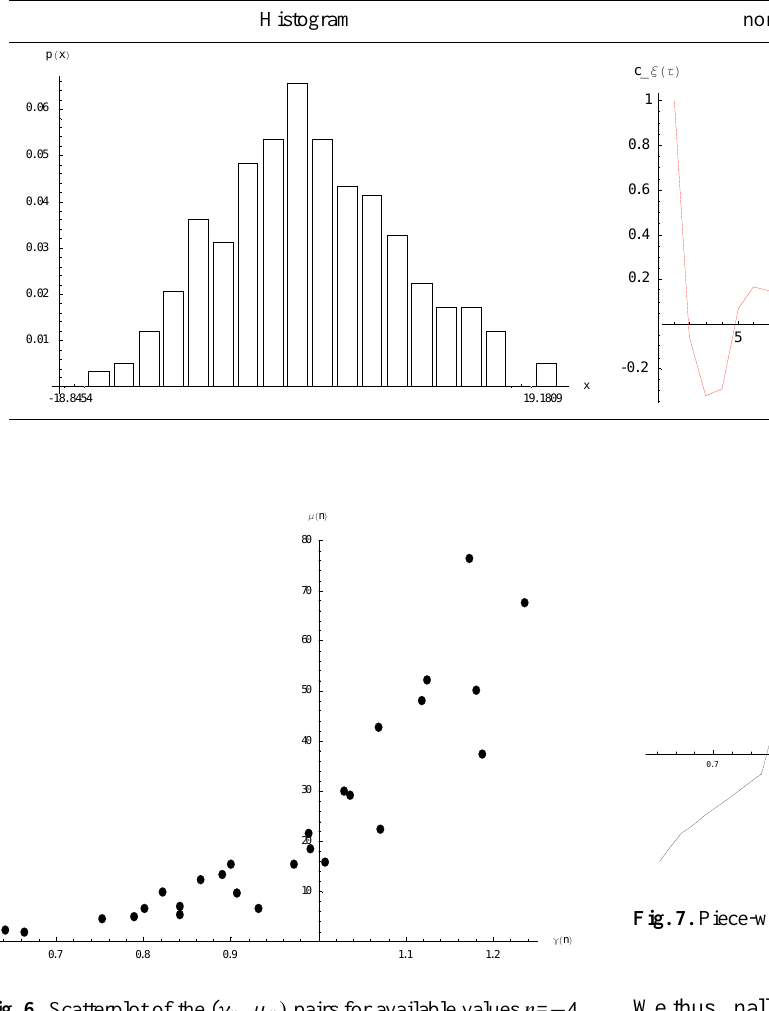
(cid:0) (cid:1) µ ∗ , γ ∗ , k =− 4 , − 3 , ..., 23, can be well k k